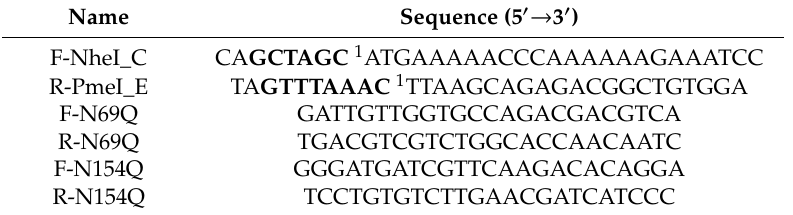
Figure 1. Generating N -glycosylation mutants of ZIKV BeH819015 in prM and / or E. ( a ) The structural genes of ZIKV BeH819015 were cloned into a pJET1.2 vector and N -glycan motif mutagenesis was introduced by overlapping polymerase chain reaction (PCR). Mutated PCR amplicons were sub-cloned into the infectious clone of ZIKV BeH819015 that contained a ZsGreen marker by using the indicated restriction endonuclease sites (red color). SP6 promoter sequence is present upstream of sequence corresponding to ZIKV genome; ( b ) Sequence chromatograms of the prM and E protein glycosylation motifs of ZIKV wild-type (WT), N69Q, N154Q or N69Q / N154Q clones. ZIKV = Zika virus; UTR = untranslated region; C = capsid protein; prM = pre-membrane protein; E = envelope protein; ZsGreen = green fluorescent protein derived from zoanthus species ; WT clone = wild-type ZIKV with the ZsGreen reporter gene; N69Q = ZIKV with a mutated N -glycosylation site in prM; N154Q = ZIKV with a mutated N -glycosylation site in E; N69Q / N154Q = ZIKV with mutated N -glycosylation sites in prM and E. Table 1. List of primers used to mutate the N -glycan motif in the ZIKV BeH819015 pre-membrane and / or envelope protein.